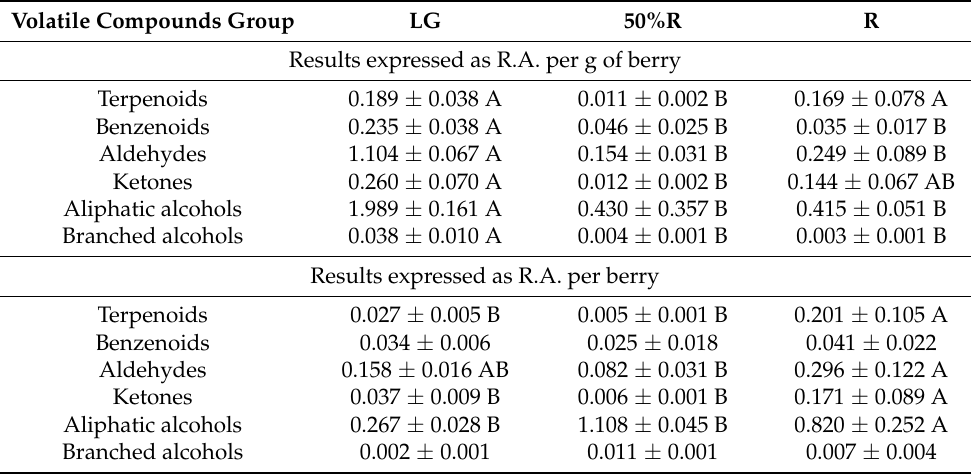
Results expressed as R.A. per g of